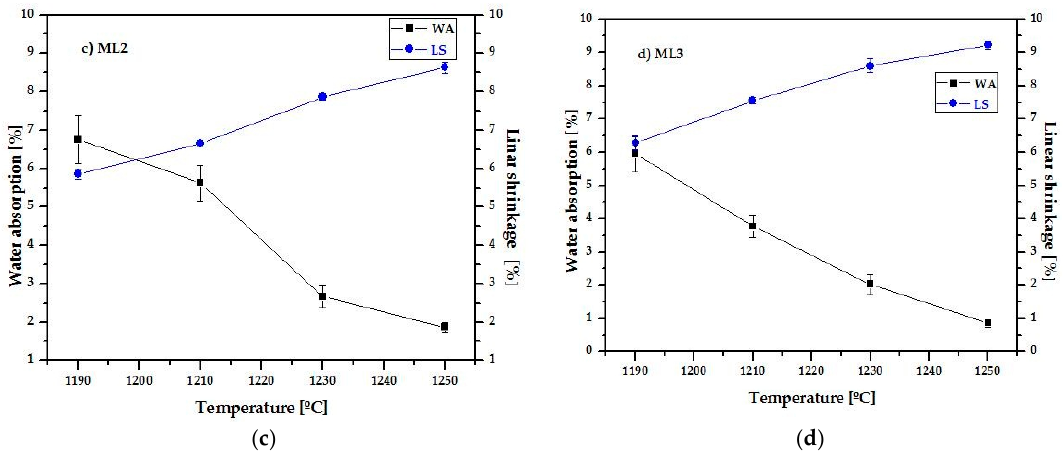
Figure 4. Gresification diagrams of the floor tile formulations: ( a ) ML0; ( b ) ML1; ( c ) ML2; and ( d ) ML3.